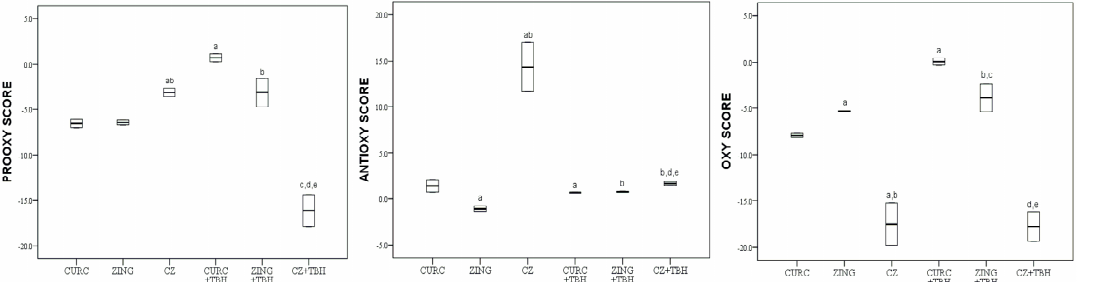
Figure 6. Values of pro-oxidative, antioxidative and oxidative scores of magnolol (MAG) and its two derivatives (M1, M2) in serum pool before and after the addition of TBH; values are represented by median (horizontal line) and interquartile range (25–75th percentile (lower and upper edge, respec- tively)). a,b,c,d,e — signi fi cant di ff erence ( (cid:31) < 0.05)compared to MAG, M1, M2, MAG + TBH, M1 + TBH, respectively .